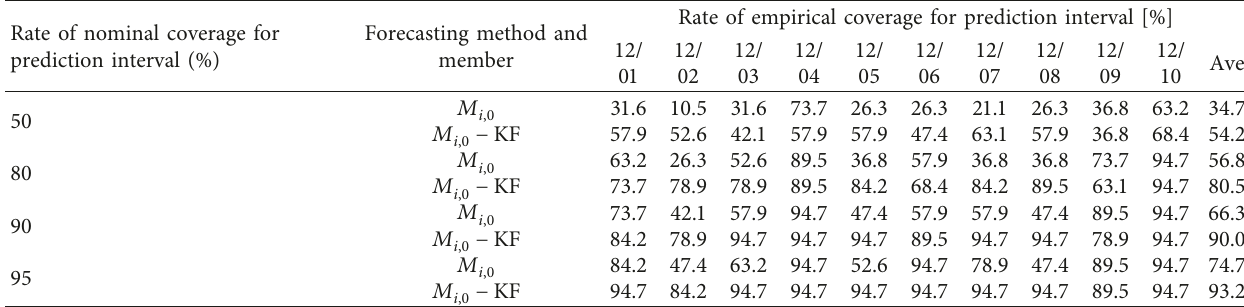
Figure 10: Time series of solar GHI intraday prediction M − KF based on model WRF and method Kalman filter, and its 50%, 80%, 90%, i, 0 − KF prediction and ensemble spread, (b) M − KF and 95% prediction interval during the period from December 1 to 10 in 2013. (a) M i, i, 0 0 − KF prediction and 80% prediction interval, (d) M − KF prediction and 90% prediction prediction and 50% prediction interval, (c) M i, i, 0 0 − KF prediction and 95% prediction interval. interval, and (e) M i, 0 Table 3: Rates of empirical coverage for the intraday solar GHI prediction with regard to the prediction interval of the ensemble prediction during the period from December 1 to 10 th 2013.